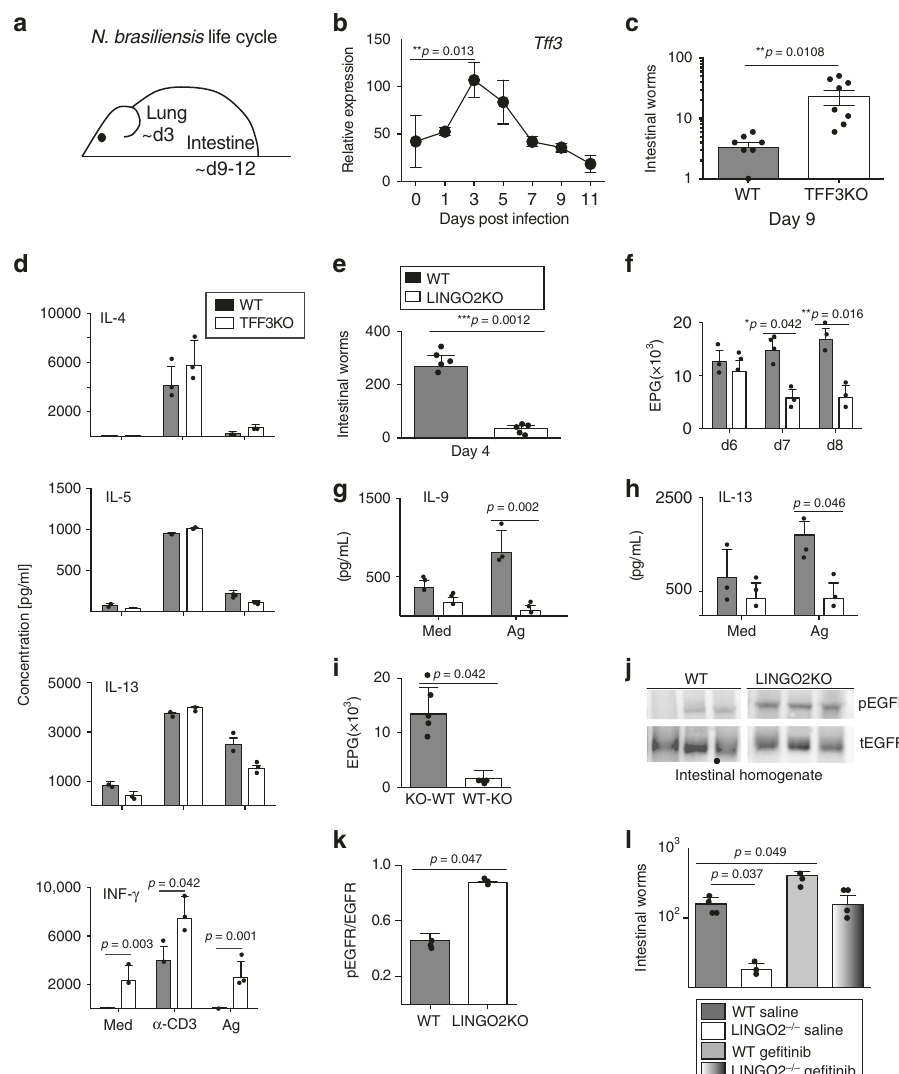
Fig. 6 A TFF3-LINGO2-EGFR axis controls host-immunity against hookworm infection. a Diagram of N. brasiliensis infection life cycle in mice. b Tff3 mRNA transcript levels in jejunum of WT C57BL/6 mice infected with 750 N. b . L 3 Data show mean ± SE of 3 or 4mice/group. c Intestinal adult worm numbers in WT vs. Tff3 KO mice at day 9 post-infection each symbol represents an individual mouse. d Secretion of IL-4, IL-5, IL-13 and IFN- γ levels from WT vs. Tff3 KO mesenteric lymph node cells isolated at day 9 post-infection. Cytokine levels in response to media alone, anti-CD3 (1 μ g/ml or N. b . crude adult extract (10 μ g/ml) at 48 h. Experiment performed twice n = 4 – 5 mice/group. e Intestinal worm numbers at day 4 post-infection 9 days post infection with N. brasiliensis in WT versus Lingo2 KO mice. Mean ± SE of 5 mice/group are shown Representative of four independent experiments. f Fecal egg numbers, shown as eggs per gram feces (EPG) in WT vs. Lingo2 KO mice at days indicated. g IL-9 and h IL-13 production from isolated MLN on day 9 exposed to media or N. brasiliensis antigen extract. i Egg load in feces on day 7 from WT → Lingo2 KO versus Lingo2 KO → WT BM chimera mice at day 4 post infection. Means ± SE of 3 or 4 mice/group are shown. j Western blot showing intestinal levels of phospho-EGFR and total EGFR in mice at day 9 post-infection. Each represents an individual mouse. k Densitometry for data shown in j . l Adult worm burdens recovered from intestinal lumen at day 9 from WT and Lingo2 KO mice treated with Ge fi tinib or vehicle during infection with N. b . infection. Means ± SE of 9 or 10 mice/group are shown. P values shown represent the results of unpaired two tail t tests except for l where two-way ANOVA analyses are shown post-irradiation and were evaluated for chimerism ef fi ciency at 6 – 8 weeks post transfer. Only animals showing >90% donor chimerism were used for subsequent Colon length was determined using a ruler at necropsy. Disease activity index data analysis as determined by anti-CD45.1 and anti CD45.2 mAb combined with (DAI) a cumulative score with a maximum of 12, was derived as follows: every lineage speci fi c Ab for CD4, B220 and CD11b and CD11c 70 . All the procedures mouse was assigned a score. 1 was for each display of lack of grooming, piloer- complied with all relevant ethical regulations for animal testing and research and ection, awkward gait, hunched posture, and lack of mobility. Diarrhea score (0, were reviewed and approved by IACUC at University of California at San Francisco (protocol #AN109782-01) and University of Pennsylvania (protocol #805911). DSS colitis and Nippostrongylus brasiliensis mouse models . Colitis was induced in mice using 2.5% DSS (w/v, 0216011080, MP-Biomedicals LLC Solon, OH) in autoclaved drinking water for 6 days. Normal water was supplied on Day 6. Mice were assessed for body weight, appearance, fecal occult blood (Fisherbrand ™ Sure- NATURE COMMUNICATIONS| (2019) 10:4408